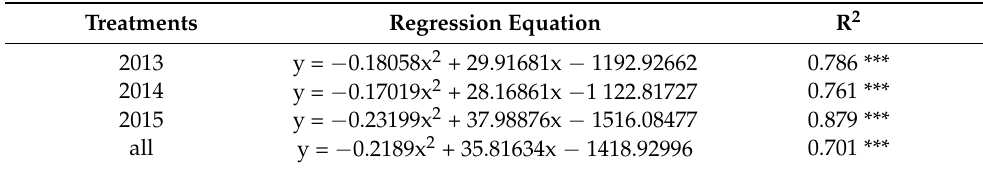
Table 3. Regression equation between leaf water content and Vcmax25 in 2013, 2014 and 2015.